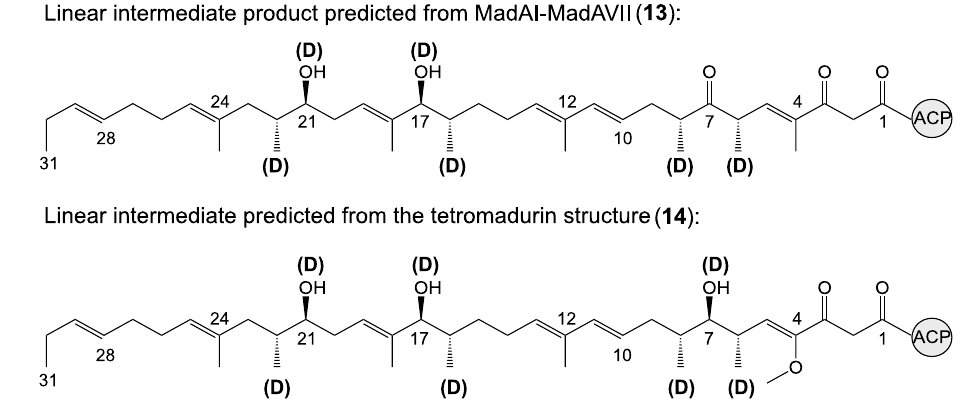
Fig 6. Hypothetical ACP-bound linear tetromadurin backbone. 13 : the hypothetical linear tetromadurin intermediate predicted to be produced by the MadAI-MadAVII arrangement. 14 : the hypothetical linear tetromadurin intermediate predicted from the structure of tetromadurin